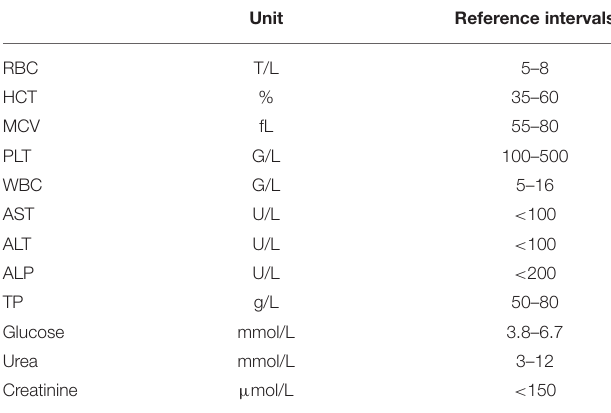
(AA Biotechnology, Poland) and used as a template for multiplex TABLE 1 | Normal reference values of investigated hematological and biochemical